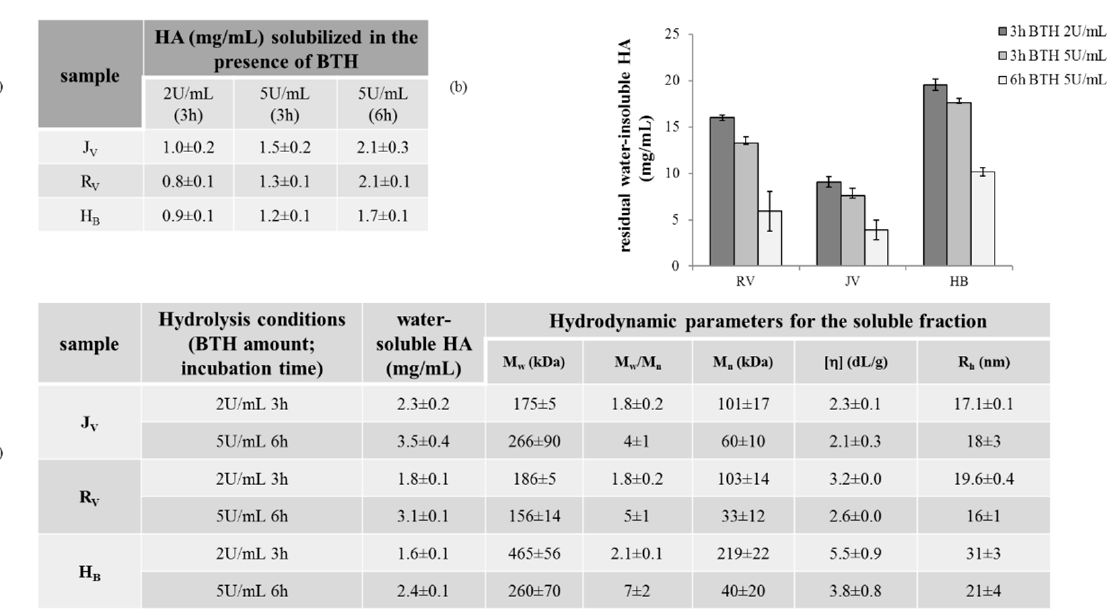
Figure 5. Enzymatic degradation. ( a ) Amount of HA (mg/mL) solubilized due to the BTH action after 3 h incubation with BTH 2 U/mL and after 3 and 6 h incubation with BTH 5 U/mL. ( b ) Residual water-insoluble HA (mg/mL) under the same hydrolysis conditions as in ( a ). ( c ) SEC-TDA data for the HA water-soluble fraction after 3 h incubation with 2 U/mL and 6 h incubation with BTH 5